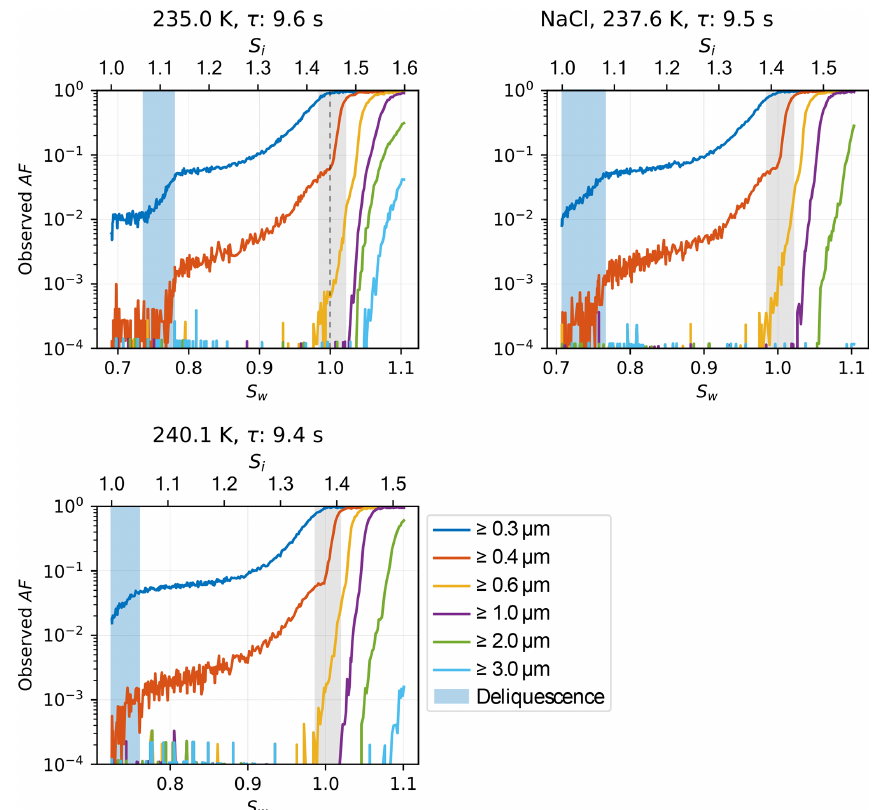
Figure A7. Relative humidity ramps showing the increase in AF during deliquescence and cloud droplet formation of 200nm sodium chloride particles at various temperatures. Light blue shading highlights the range of observed deliquescence; grey shading refers to chamber uncertainty (see Sect. 3.1 for